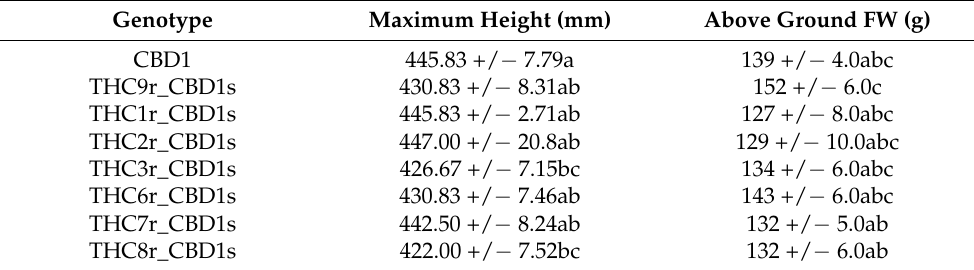
Table 3. Height (mm) and total above ground fresh weight (FW) (g) of CBD1 plants and CBD1 scions grafted to seven different rootstocks. N = 5–6 +/ − standard error. Different letters denote significant differences between genotypes/grafts (Tukey HSD test, p ≤ 0.05).